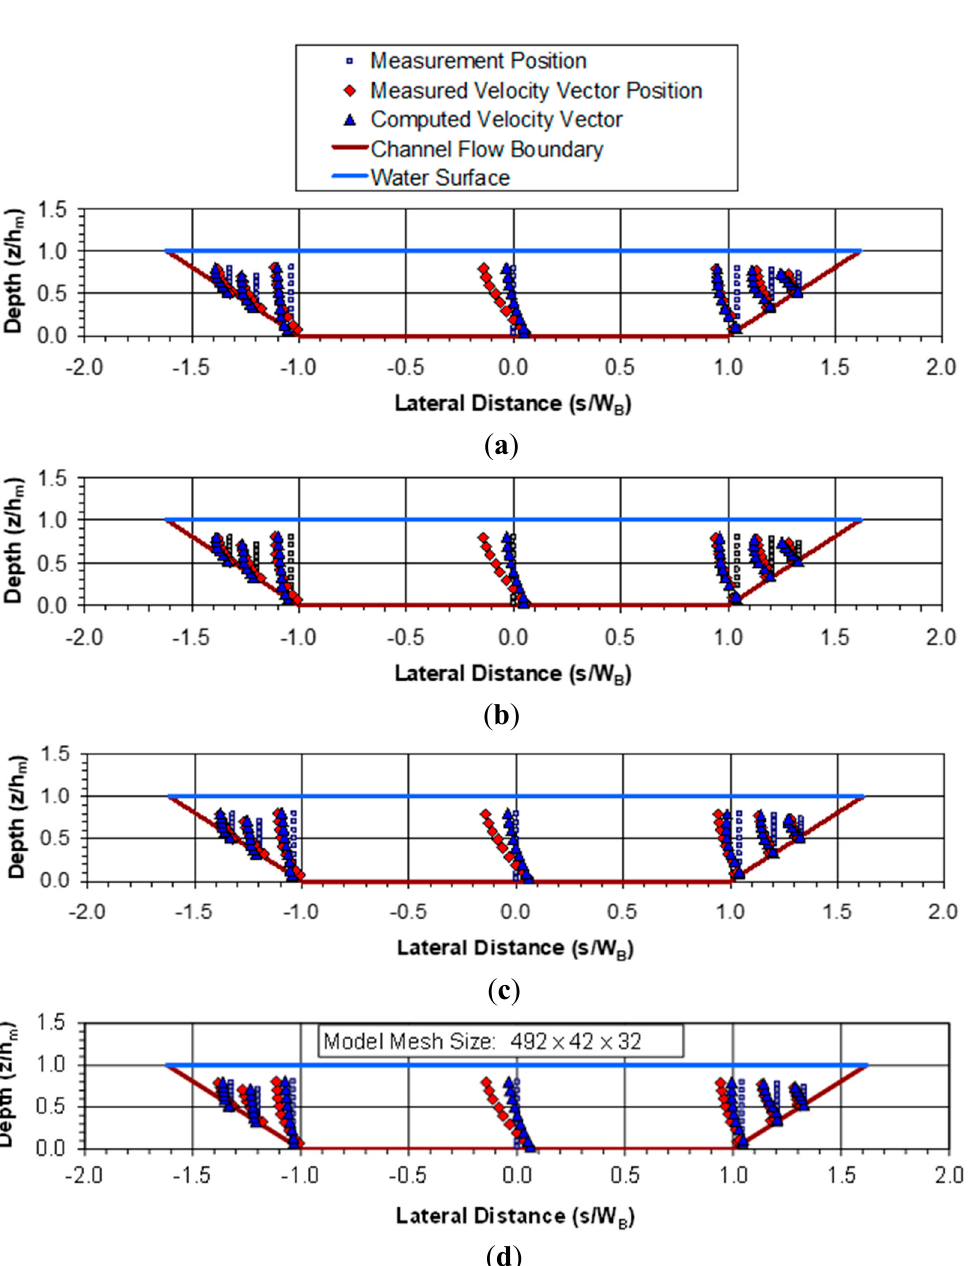
Figure A17. Comparison of simulated and measured cross-stream velocities at Cross-section 6 using four different 3D mesh sizes. ( a ) 327 × 21 × 16; ( b ) 492 × 21 × 16; ( c ) 492 × 32 × 24; ( d ) 492 × 42 × 32.